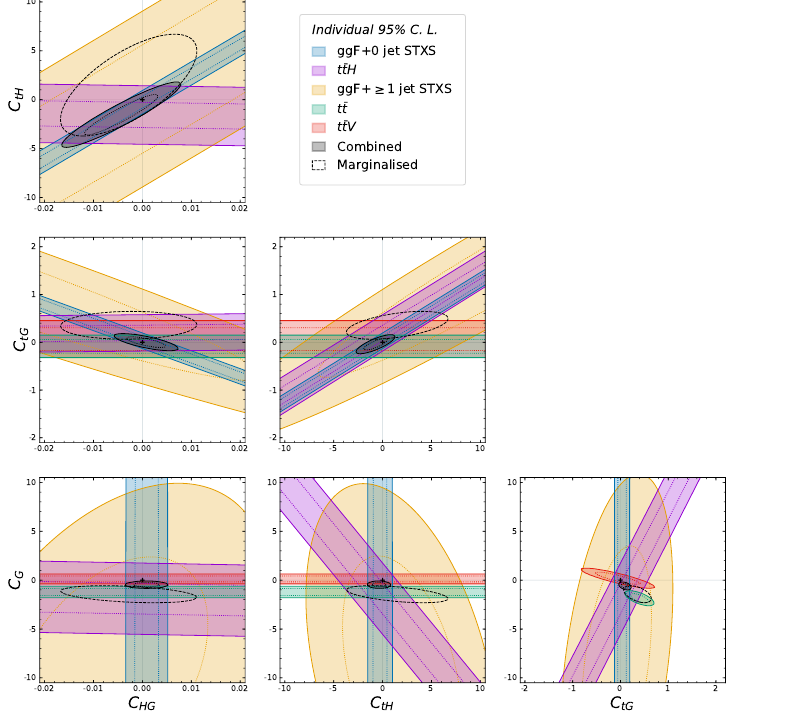
Figure 8 . Constraints on the indicated pairs of operator coefficients at the 95% confidence level, setting the other operator coefficients to zero. The shaded regions correspond to linear fits to Higgs signal strengths and 0 jet STXS bins (blue), t ¯ tH signal strengths (mauve), ≥ 1 jet STXS bins (orange) t ¯ t data (green), t ¯ tV data (red) and their combination (grey). The dashed ellipses show the constraints obtained by marginalising over the remaining Wilson coefficients of the full